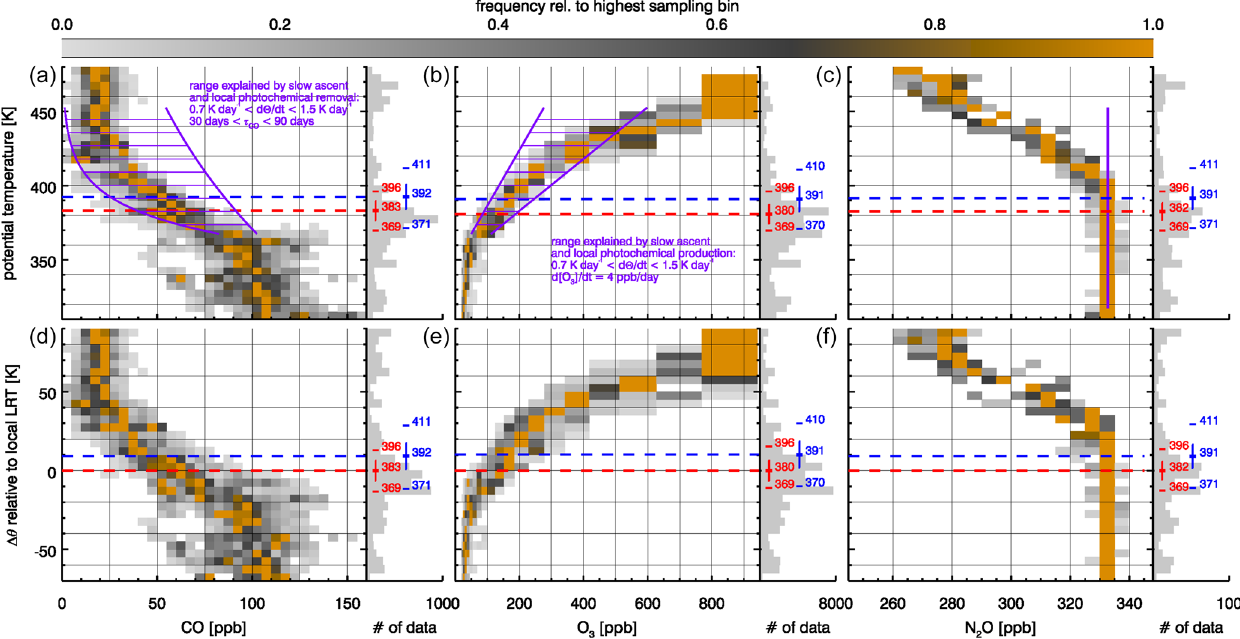
Figure 4. Layer-normalized relative frequency distributions of CO (a, d) , O 3 (b, e) and N 2 O (c, f) inside the ASM anticyclone (MeqLat > 65 ◦ ) for vertical coordinates of potential temperature (a–c) and potential temperature difference relative to the local LRT (d–f) . The number of observations on each vertical level is plotted as the grey histogram along the right side of each panel (scaling from 0 to the number at the right end of the axis). The mean (with standard deviation), minimum and maximum LRT and CPT levels are also shown in red and blue, respectively (values vary slightly between the columns, because as explained in the Fig. 3 caption, the bins with valid measurements are different for each instrument). Areas marked in purple in the CO and O 3 panels indicate the range of concentrations consistent with photochemical removal or production during slow ascent (see text for the rationale behind the chosen ranges). In the N 2 O panel, the purple line denotes the average HAGAR N 2 O in the troposphere (below 360K potential temperature) during the 2017 campaign.